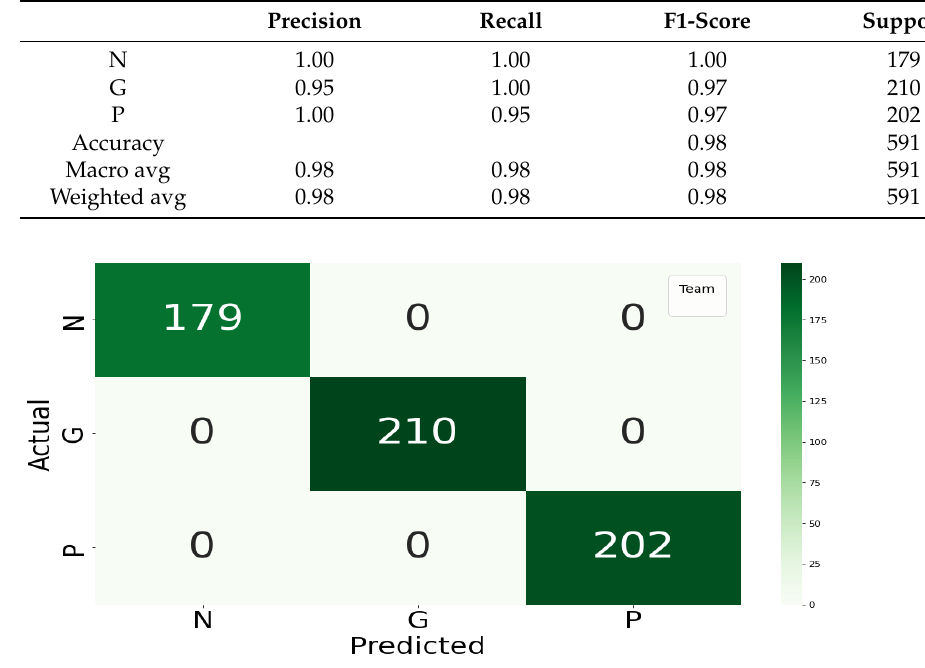
Figure 17. Confusion Matrix from Random Forest classifier.